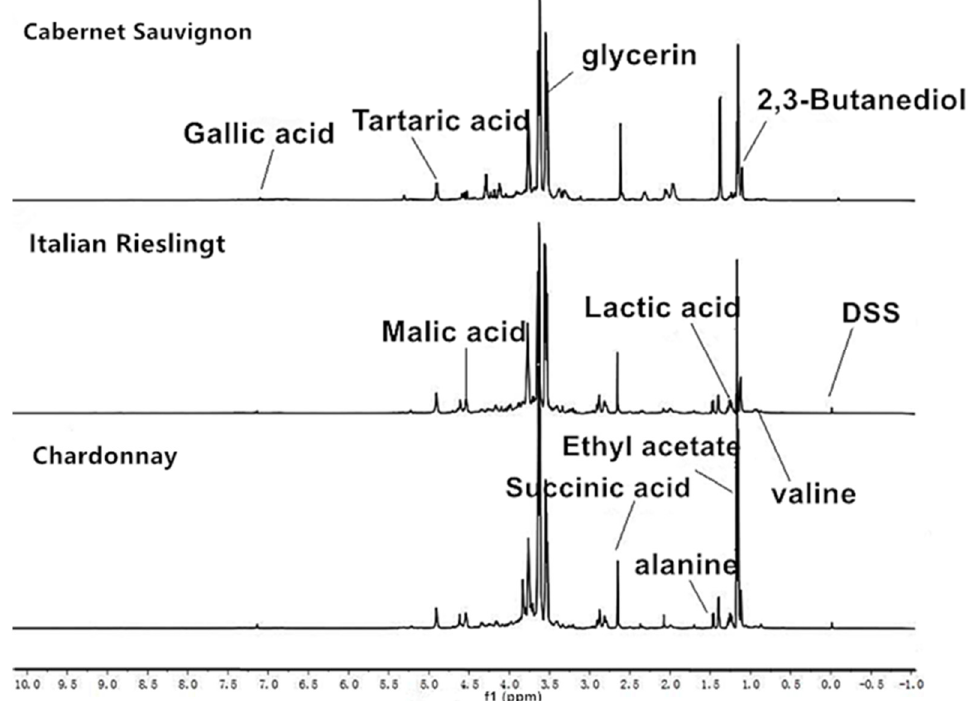
Figure 5. Titratable acid of grapes during preservation with different packaging films.